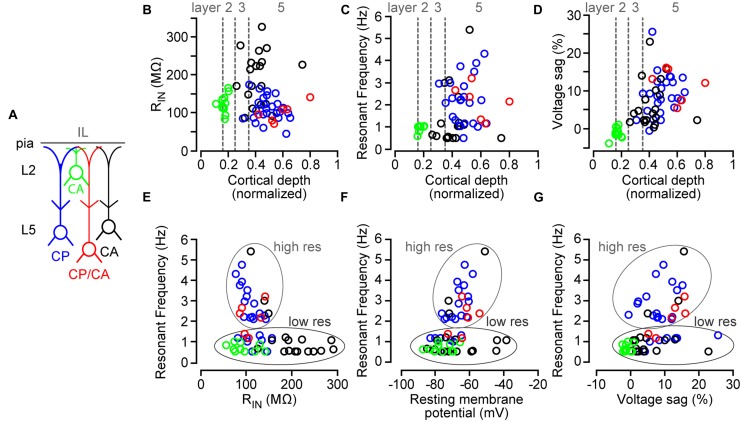
Comparison of subthreshold properties as a function of cortical depth in IL and resonant frequency. (A) Schematic showing the subclasses of neurons tested. (B) Input resistance, (C) resonant frequency, and (D) voltage sag as a function of normalized (pia = 0, white matter = 1) soma location for projection neuron classes. Mean normalized location of laminar borders are indicated with dashed gray lines. Plots of resonant frequency values versus (E) input resistance (RIN), (F) resting membrane potential, and (G) voltage sag percentage. High res = high resonators; low res = low resonators.